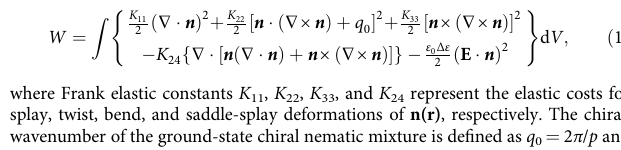
(Table 1), design of LC cell geometry, and strength of surface boundary conditions, and so on. Collective motion effects could be obtained both when simply using (e.g., at 1kHz) at modulation frequencies that again yield modulation periods comparable to the LC ’ s response time. The large range of possibilities exists in terms of controlling the skyrmion schooling by varying electric signal waveforms, modulation, and carrier frequencies, and so on, but detailed exploration of all these possibilities is outside the scope of our present study.